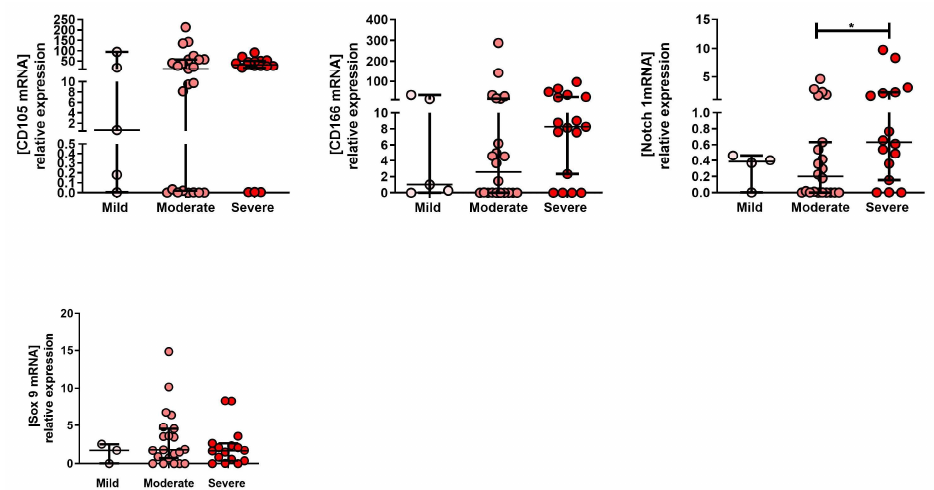
Figure 2. MPC marker expression in different OA grades. The mRNA expression levels of CD105, CD166 and Notch 1 (MPC markers) in tissue (D0) isolated from mild, moderate and severe OA grades. * p < 0.05, non-parametric Kruskal–Wallis and Mann–Whitney test.